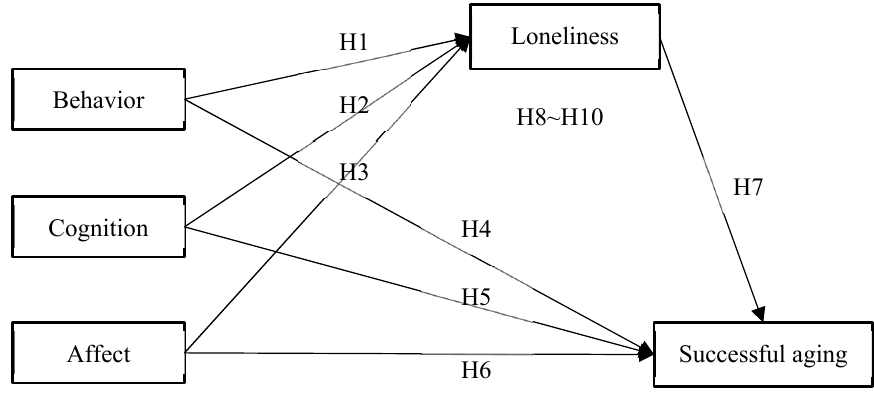
Figure 1. Proposed conceptual model.